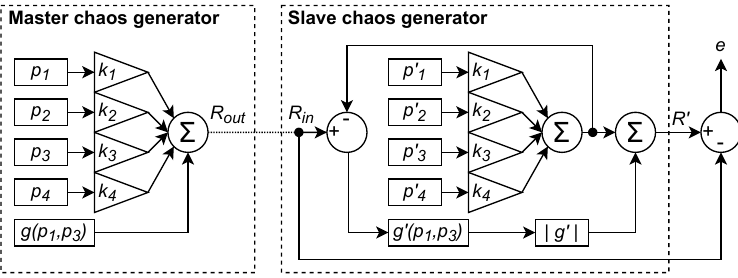
Figure 2. Block diagram of master and slave chaos